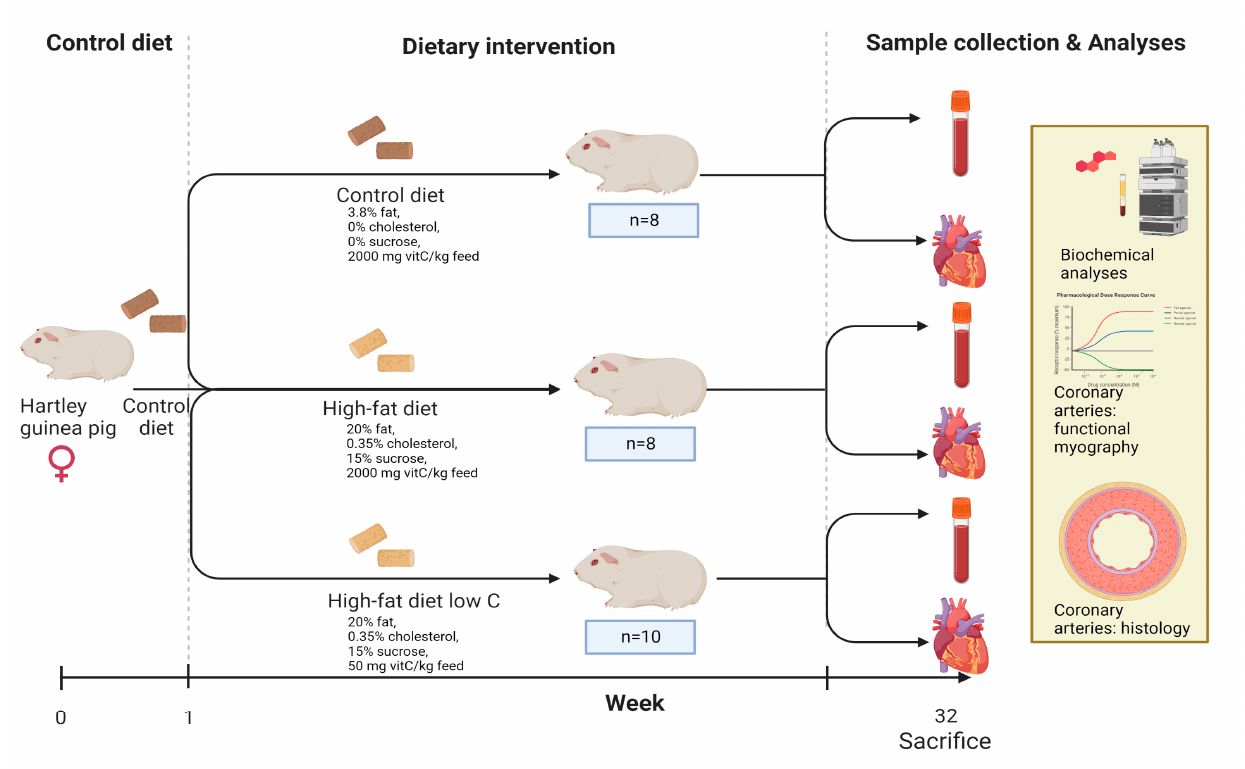
Figure 1. Experimental design of in vivo study. Created using Biorender.